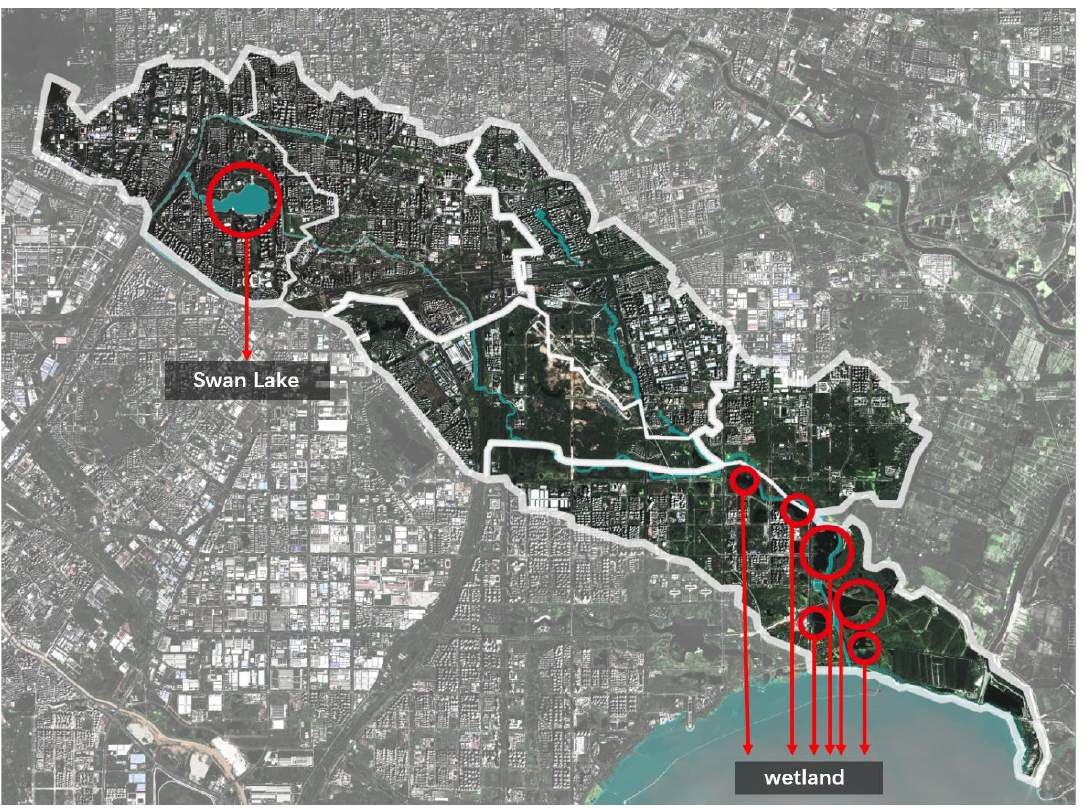
Figure 10. Swan Lake and the downstream wetland.